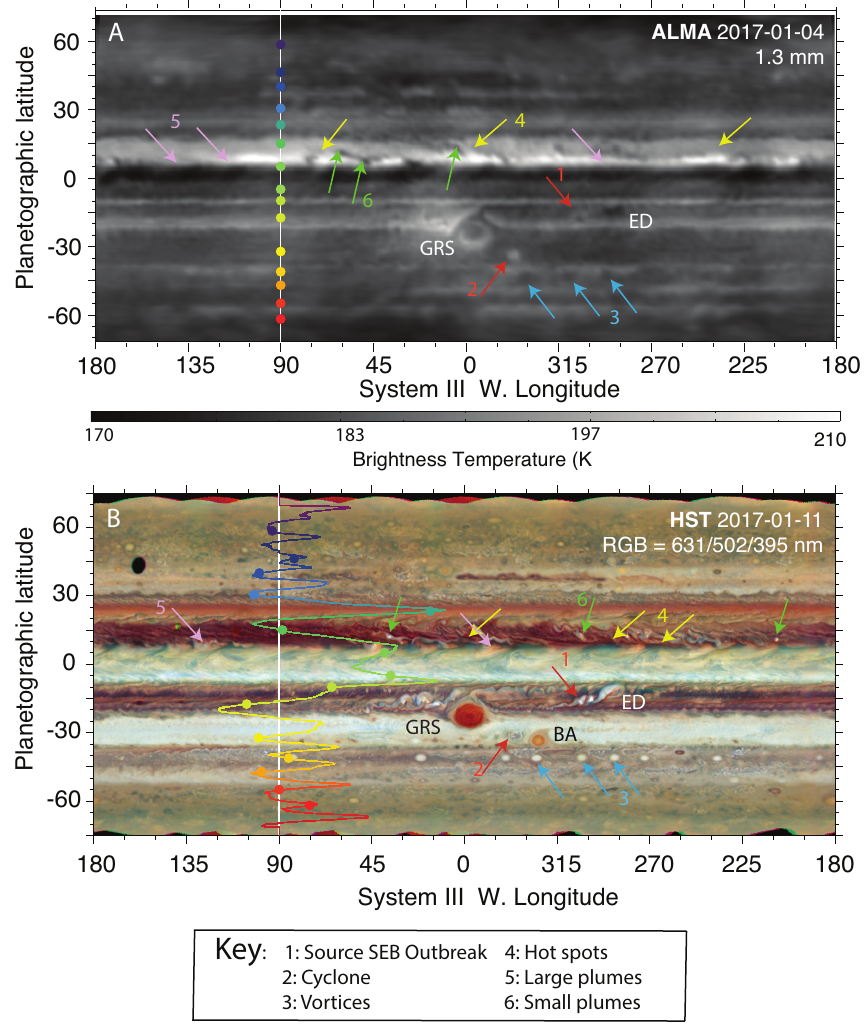
corners. The 2-cm and 3-cm data were taken on 9 January 2014; the 5-cm data on 4 May 2014. The top panel shows a visible-light map taken on the same day as the 2 and 3-cm radio maps; this map has been compiled by the amateur community. In addition to the GRS and Oval BA, several features are indicated: hot spots (yellow), ammonia plumes (red), small vortices (cyan). (Adapted from [13,97]).